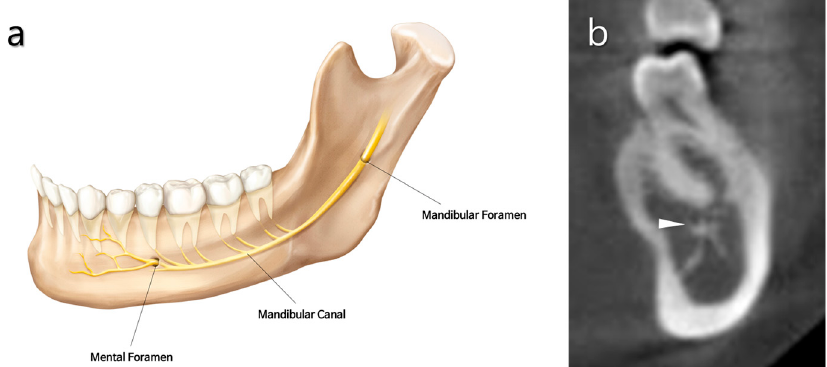
Figure 4. Anatomical features of the mandibular canal and mental foramen. ( a ) Schematic illustration of human mandible showing the innervation of mandibular and mental nerves. ( b ) Transverse section of a cone-beam compute tomography (CBCT) scan through the mandible in the region of the root of the first molar. The mandibular canal (white triangle) is closely located lingual to the root apex.